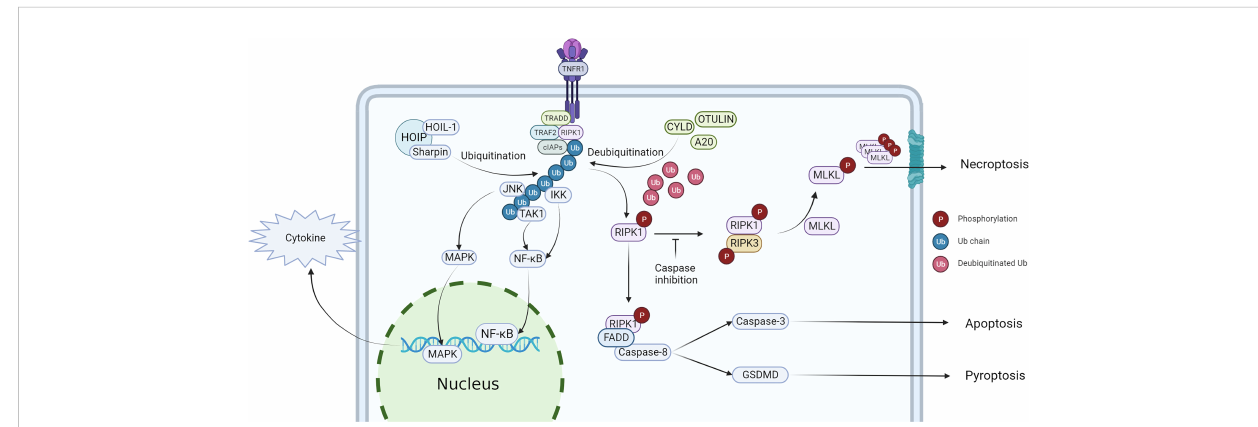
FIGURE 2 Regulation of RIPK1 and downstream effect. After stimulated by TNF- a , TRADD, TRAF2, RIPK1 and cIAPs would recruit to the intracellular terminus of TNFR1, then RIPK1 is ubiquitinated to form complex I, activating NF- k B and MAPK pathway. When RIPK1 has been deubiquitinated, the cell death pathway would be activated, triggering necroptosis, apoptosis and